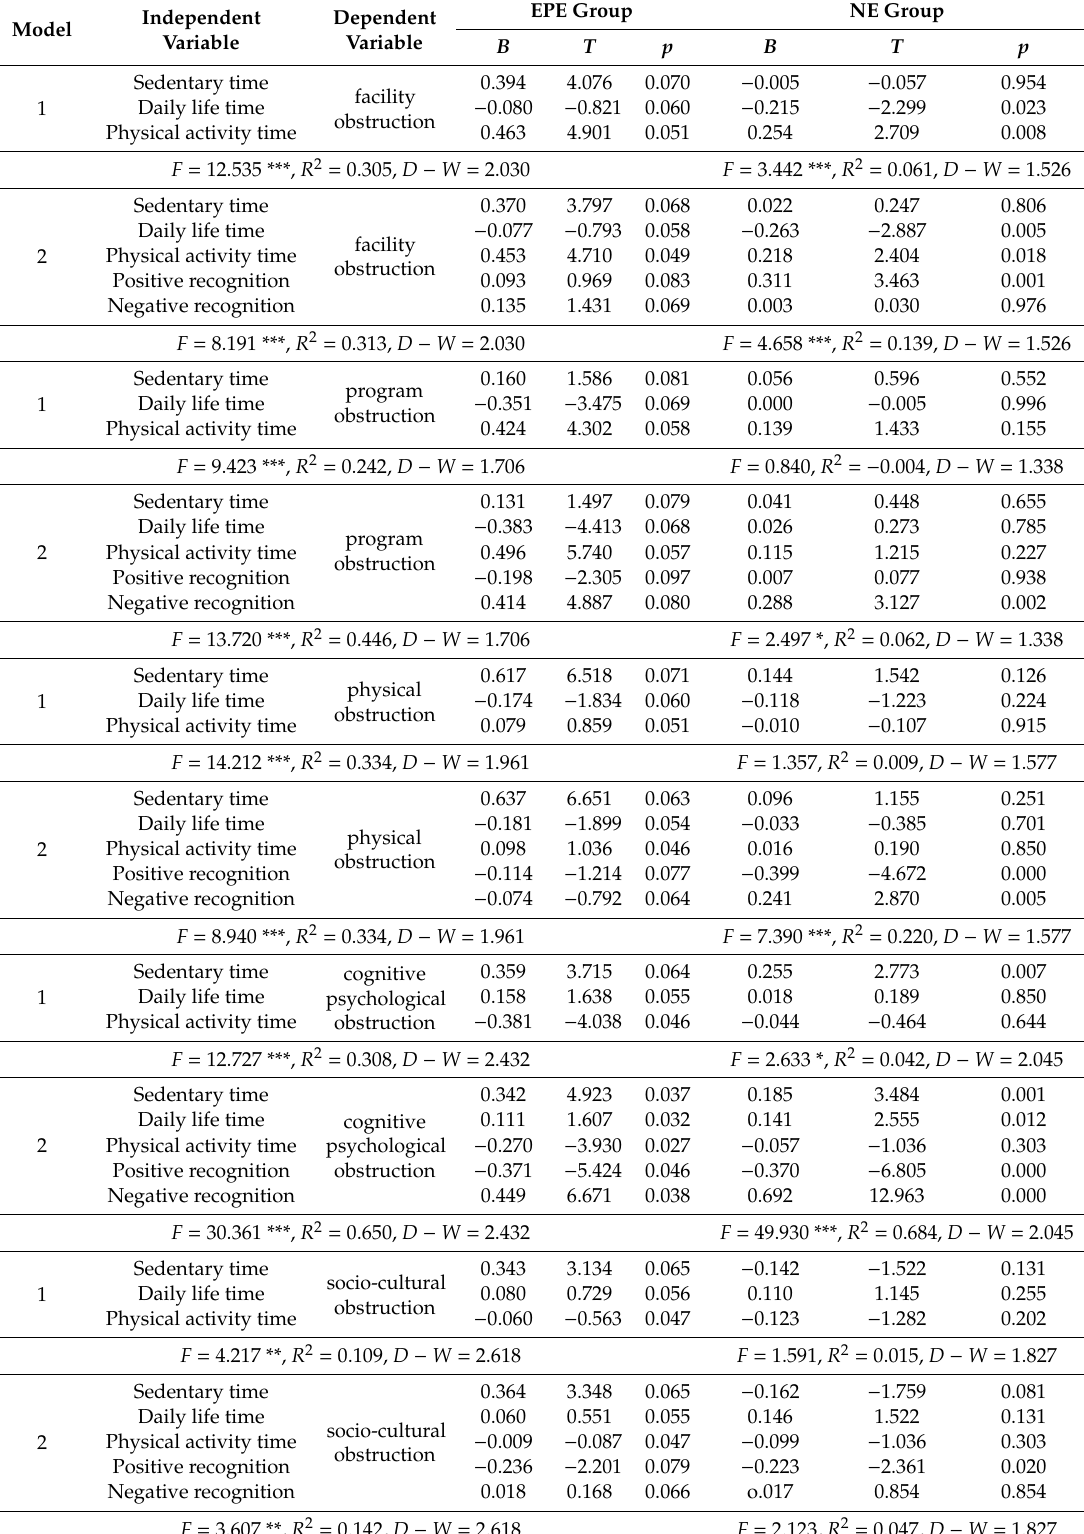
Table 2. Results of the hierarchical regression analysis for the e ff ects of the physical activity levels and obstruction factors based on the physical activity participation